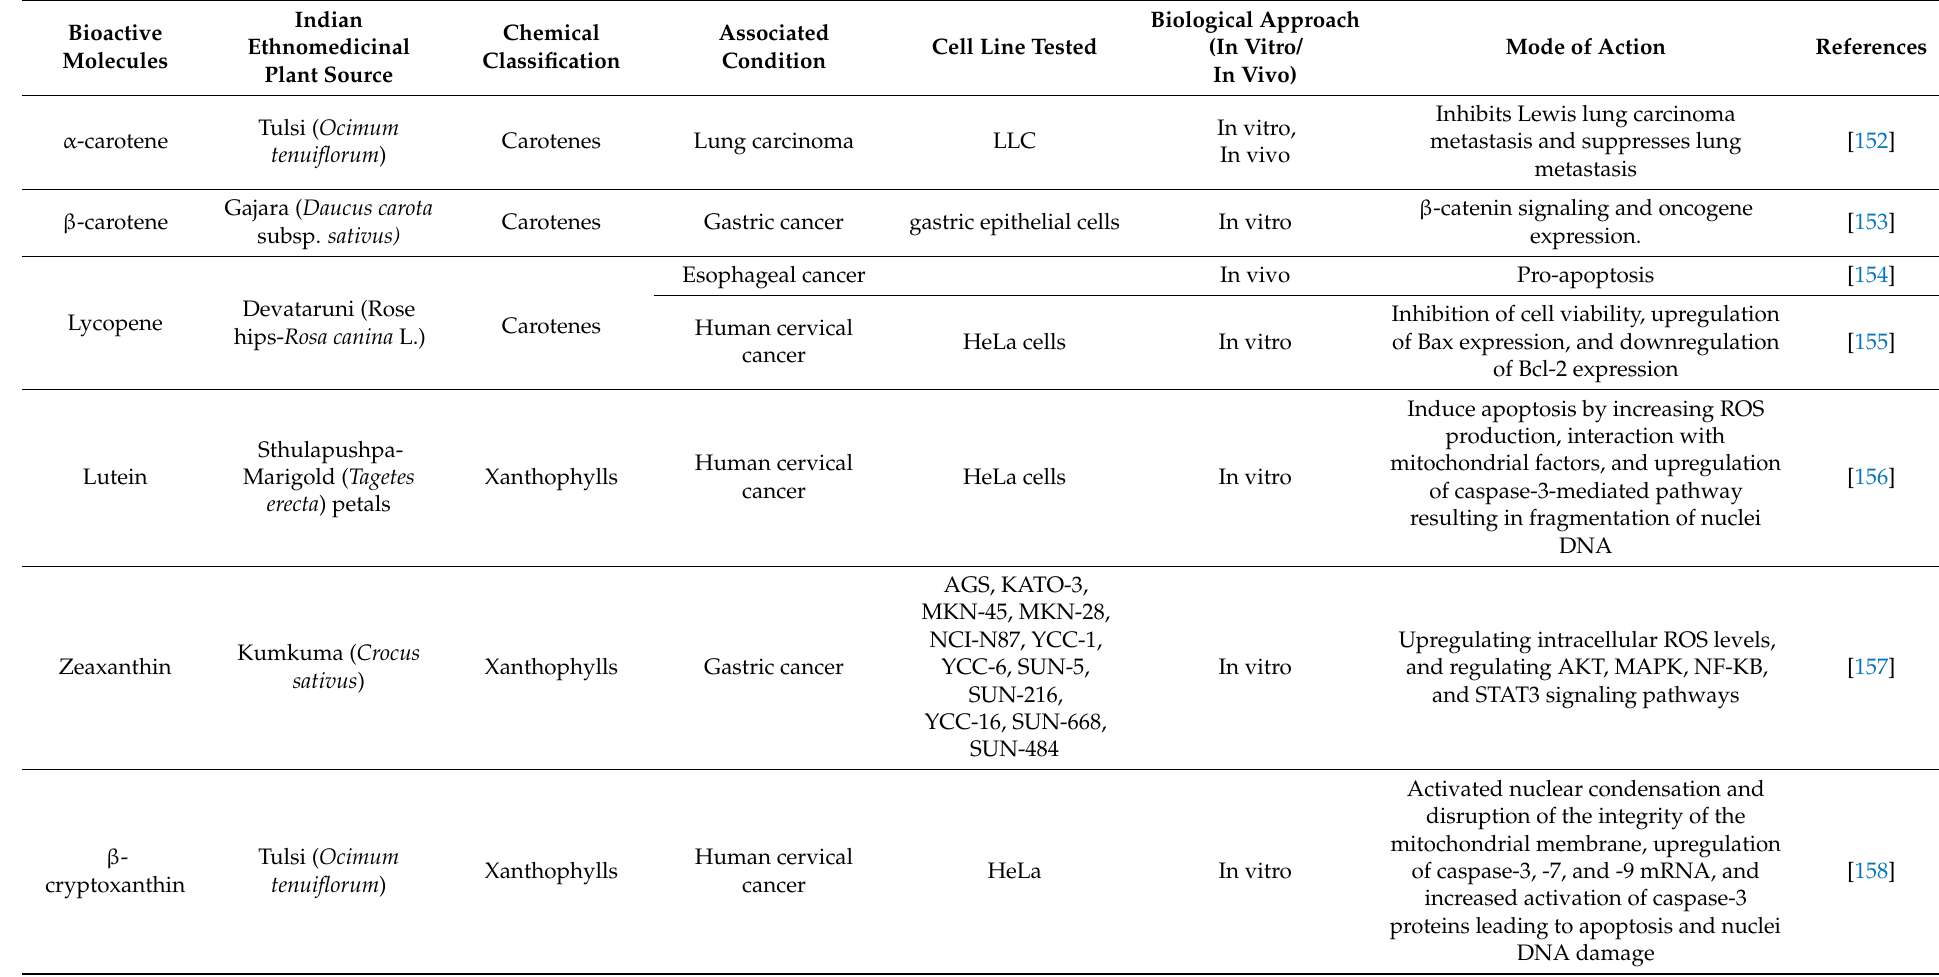
Table 6. Anticancer activity of some potent antioxidant carotenoids (recent